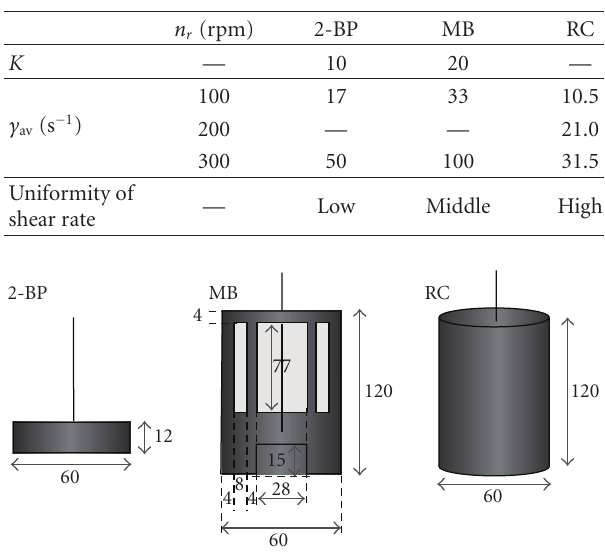
Table 1: The characteristics of three impellers used in the present study.